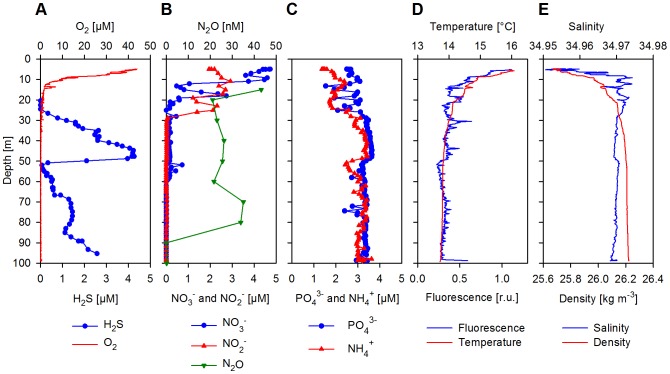
Vertical distribution of physical, chemical and biological water properties.(A) Concentrations of H2S and O2. (B) Concentrations of NO3
−, NO2
− and N2O. (C) Concentrations of PO4
3− and NH4
+. (D) In situ fluorescence (chlorophyll, relative units as measured with the pump-CTD) and temperature. (E) Salinity and density.